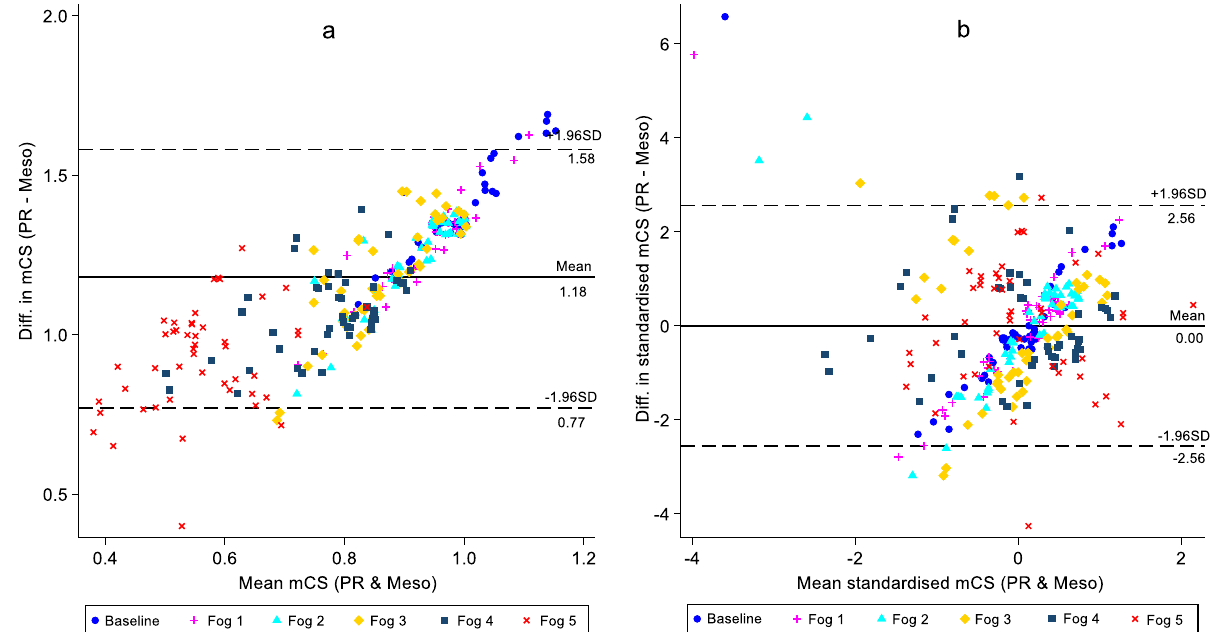
Figure 7. Bland–Altman plot of raw ( a ) and standardised ( b ) mesopic contrast sensitivity (mCS) measures between Pelli-Robson chart (PR) and Mesotest II (Meso) at baseline and with all Fog filters. Solid lines represent the mean difference in mesopic CS between the two instruments while dashed lines represent the 95% upper and lower limits of